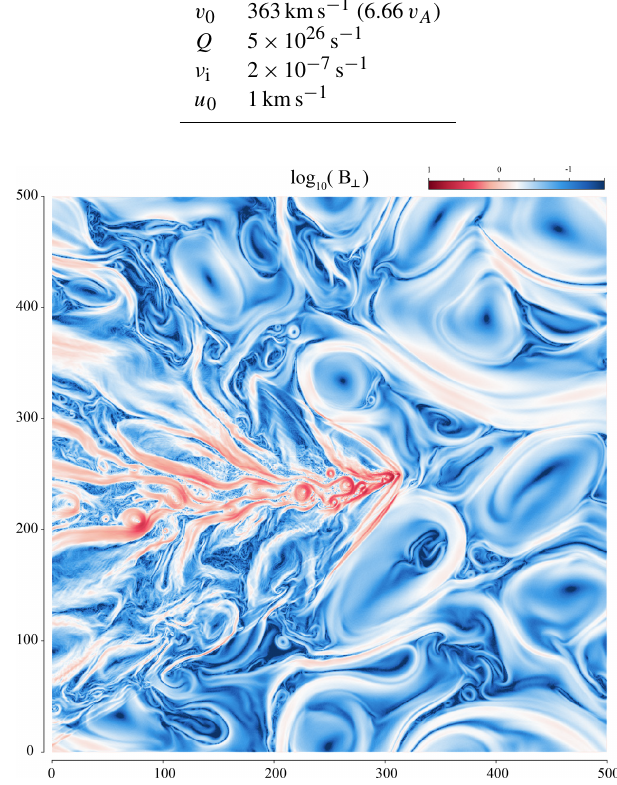
Figure 8. Perpendicular magnetic fluctuations during the interac-